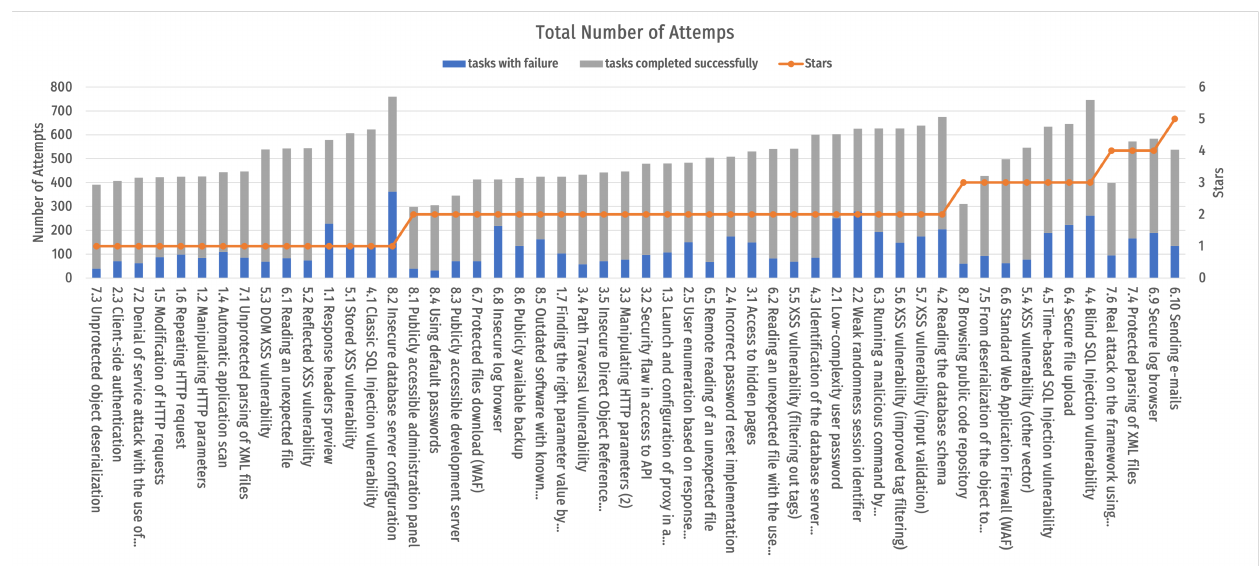
Figure 12. Total time spent on each task with the set difficulty level.